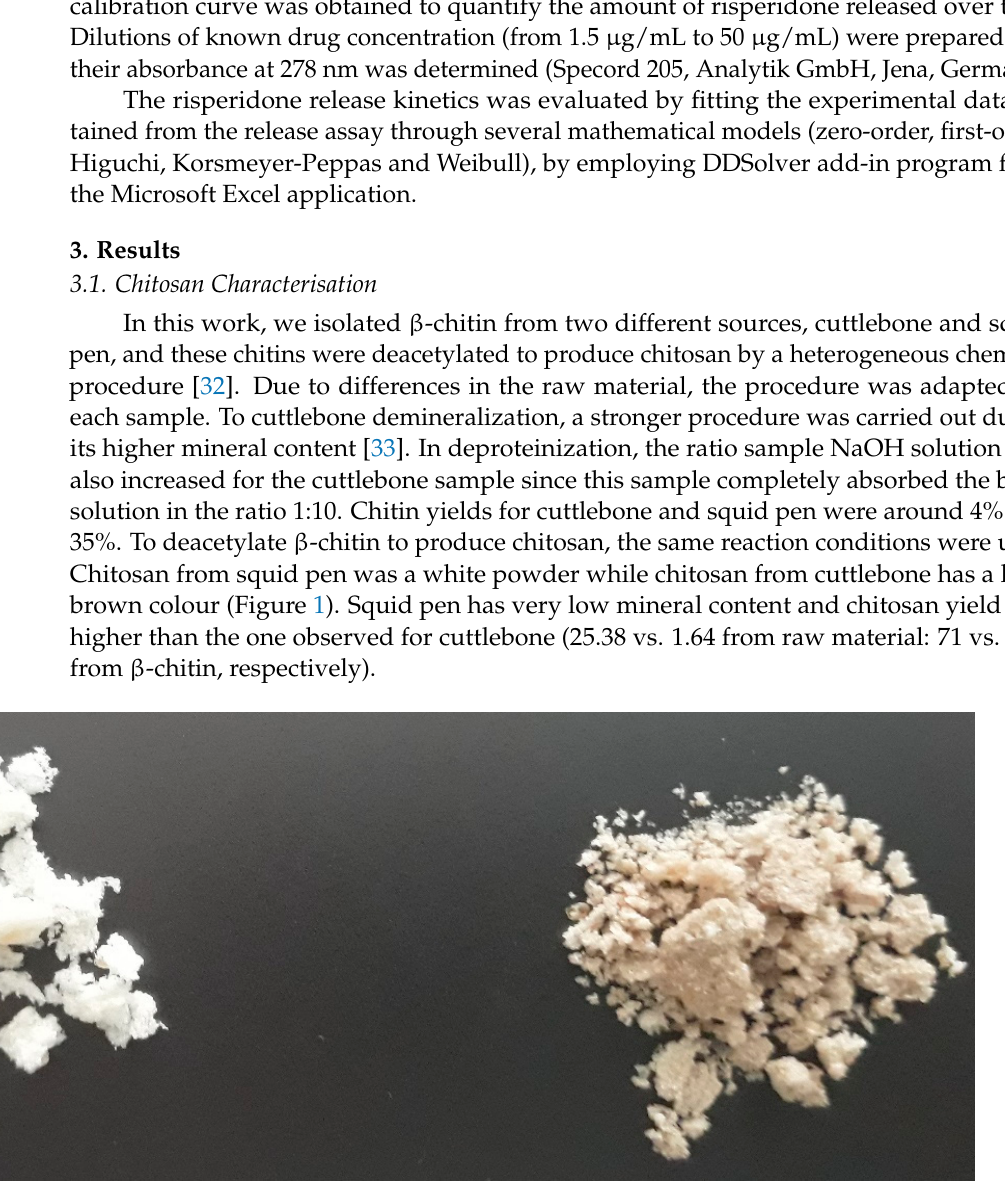
Figure 1. Optical visualization of chitosan samples. Squid pen chitosan ( left ) and cuttlebone chitosan ( right ). Table 2. Chitosan Characterization.